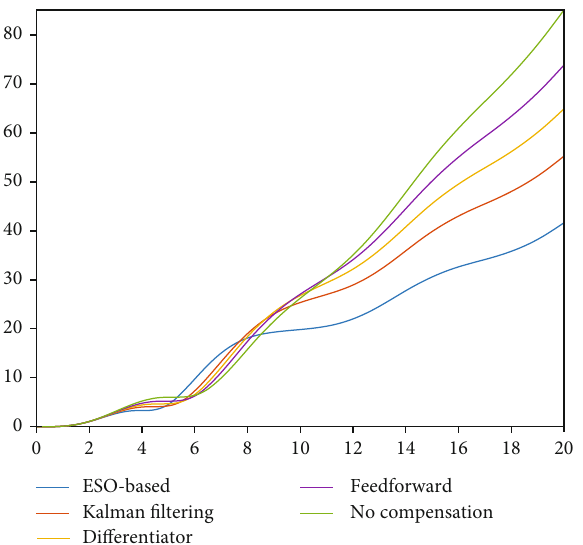
Figure 27: E ff ect of line-of-sight angle extraction.